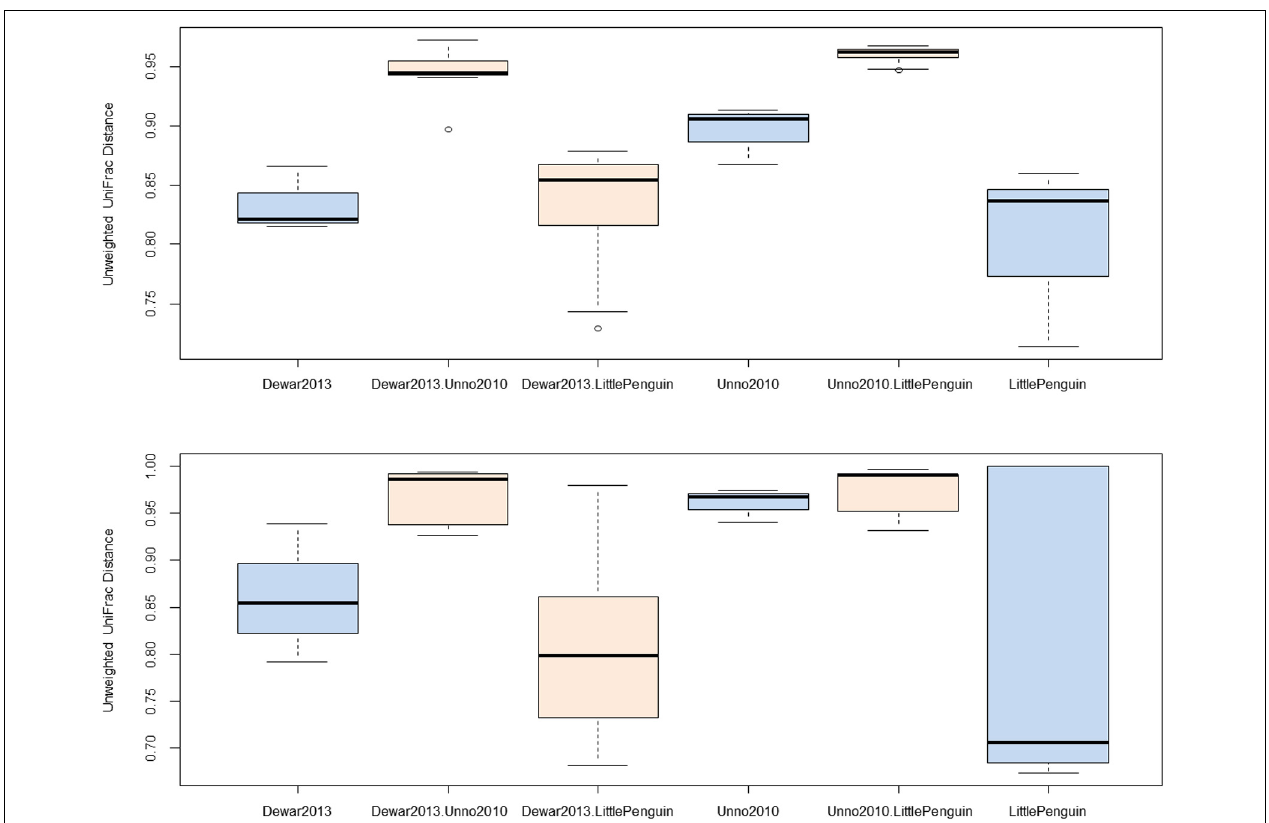
FIGURE 2 | Unweighted UniFrac distances for within- and between-study comparisons. Distances were calculated by extracting reads classified as Clostridium (top) and Bacteroidetes (bottom) from each sample and constructing neighbor-joining phylogenetic trees based on average-neighbor distances between aligned sequences. Differences between each pair of samples were categorized as being the distance